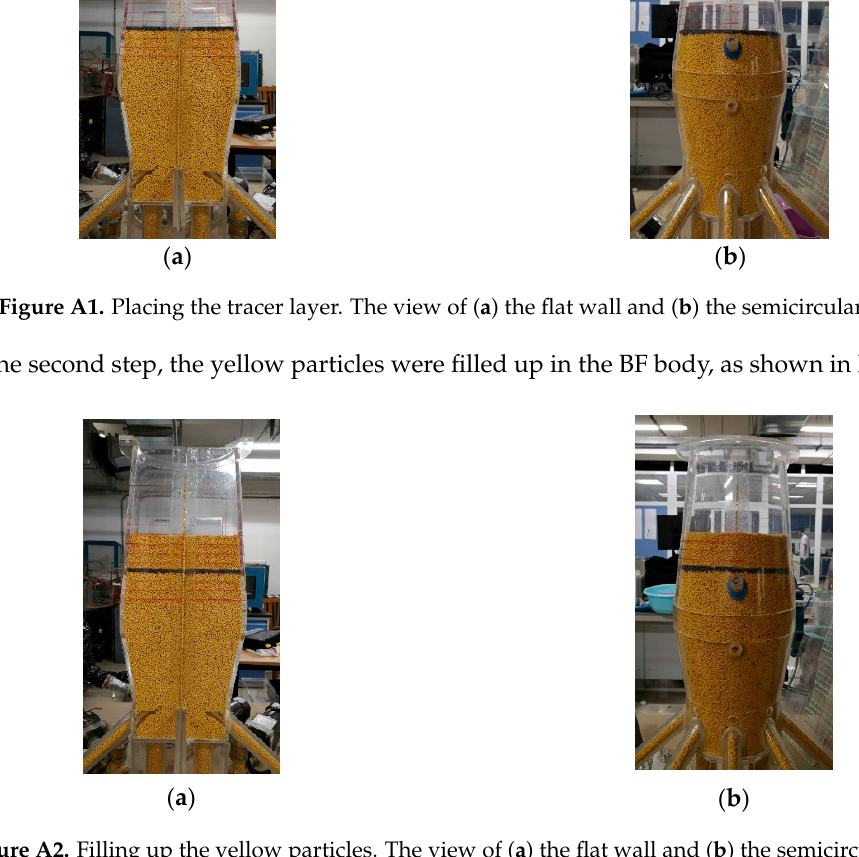
Figure A2. Filling up the yellow particles. The view of ( a ) the flat wall and ( b ) the semicircular